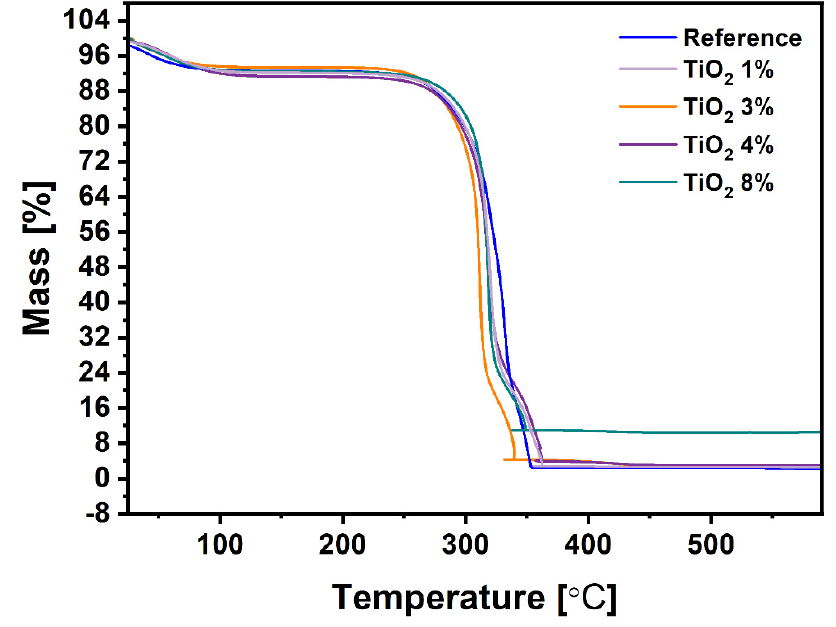
Table 1. Data obtained from TGA analysis and International Organization of Standard (ISO) ash content for all samples.